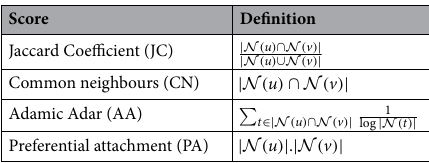
Table 2. Definition of the heuristic scores of a link ( u , v ) in the graph G ( V , E ). N ( u ) denotes the set of neighbour nodes of node u ∈ V in G ( V , E ).